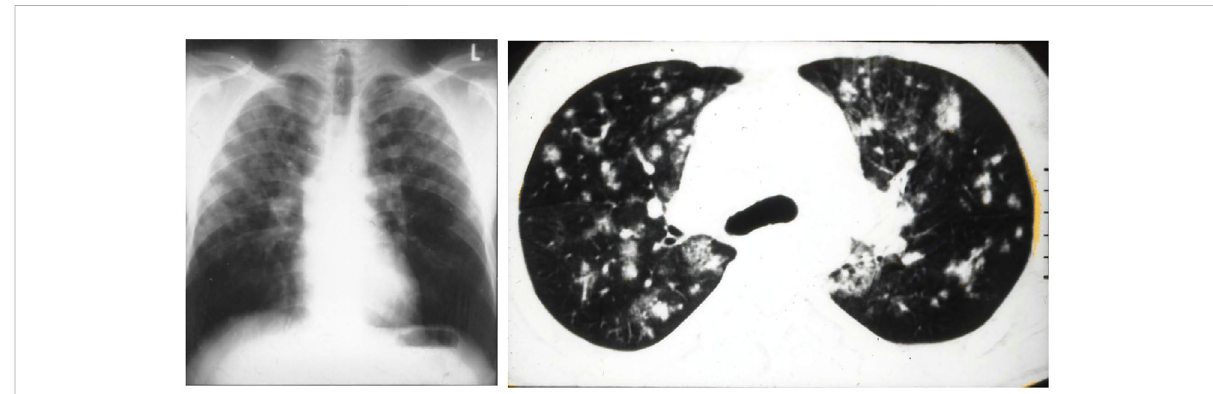
FIGURE 2 Figure 1 (A) radiograph of a 37-years-old male mountaineer with high-altitude pulmonary edema (HAPE) that shows a patchy to con fl uent distribution of edema, predominantly on the right side. (B) computerized tomography scan of 27-year-old mountaineer with recurrent HAPE showing patchy distribution of edema. Taken from Bärtsch, P, Mairbäurl, H., Maggiorini, M., Swenson, E. 2005. Physiological aspects of high-altitude pulmonary edema. J Appl Physiol, 98, 1101 –